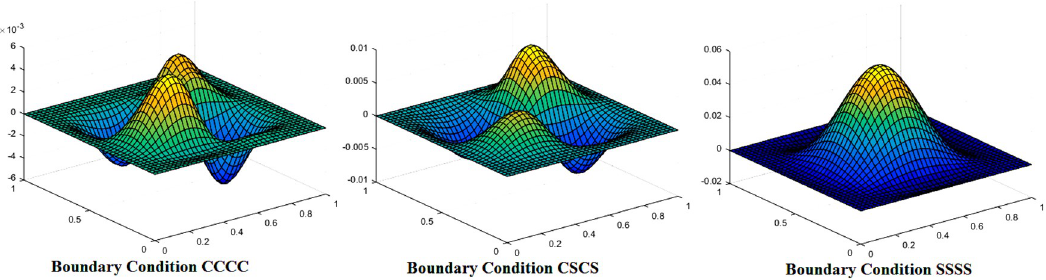
Figure 6. Mode shape for laminated composite plate with lamination scheme C, a / h = 5, N x /N y = 1, N xy = 1 and M = 2 . Table 9. ( a ) Non-dimensional buckling load for a bi-axial buckling of a composite plate having lamination scheme A and central square cutout; ( b ) Non-dimensional buckling load for a bi-axial buckling of a composite plate having lamination scheme A and central square cutout.